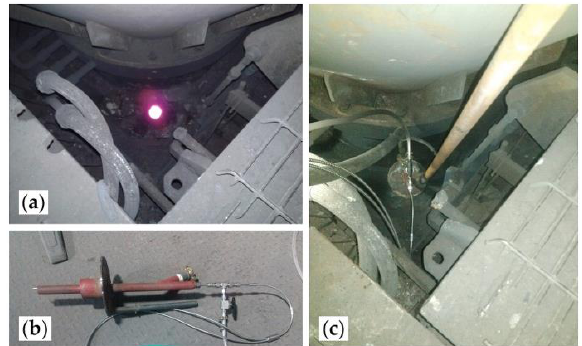
Figure 3. Industrial measurement setup: ( a ) smelter top peephole; ( b ) steel cooled protecting probe and cooled optical fiber; ( c ) mounted probe.